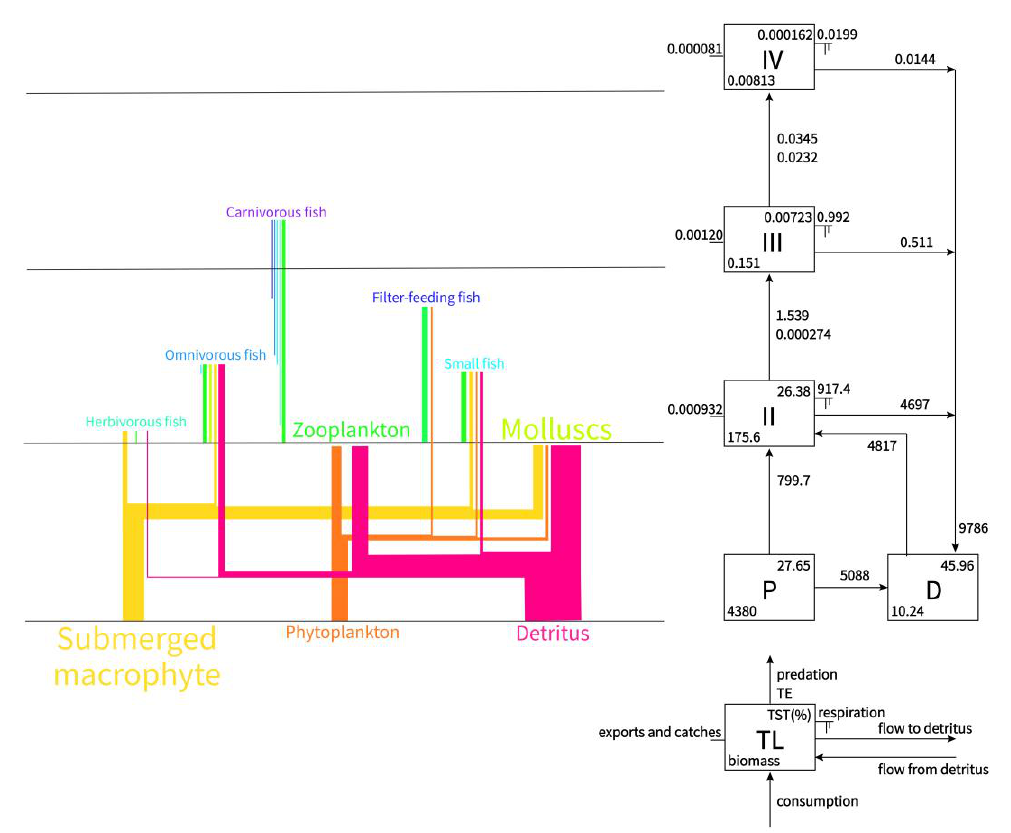
Figure 3. Flow diagram (left) and Lindeman spine (right) of the Lake Datong food web. Different colors correspond to different functional groups, the thickness of each line segment denotes the relative energy flow, and the font size represents the relative biomass. P: producer; D: detritus; TL: trophic levels; TST (%): total system throughput (%); TE: transfer efficiency.